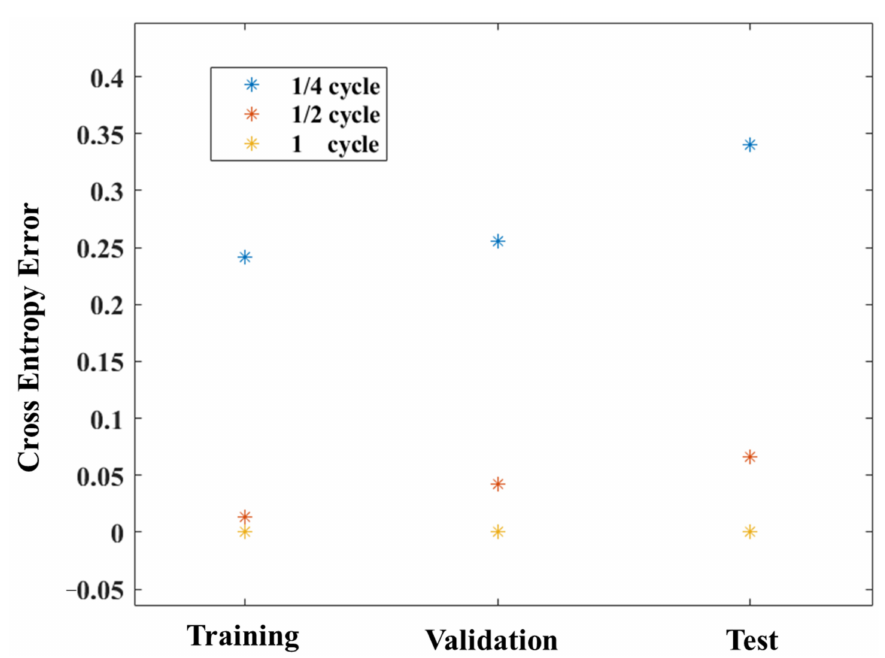
Figure 15. Fault location CEE by input cycle.